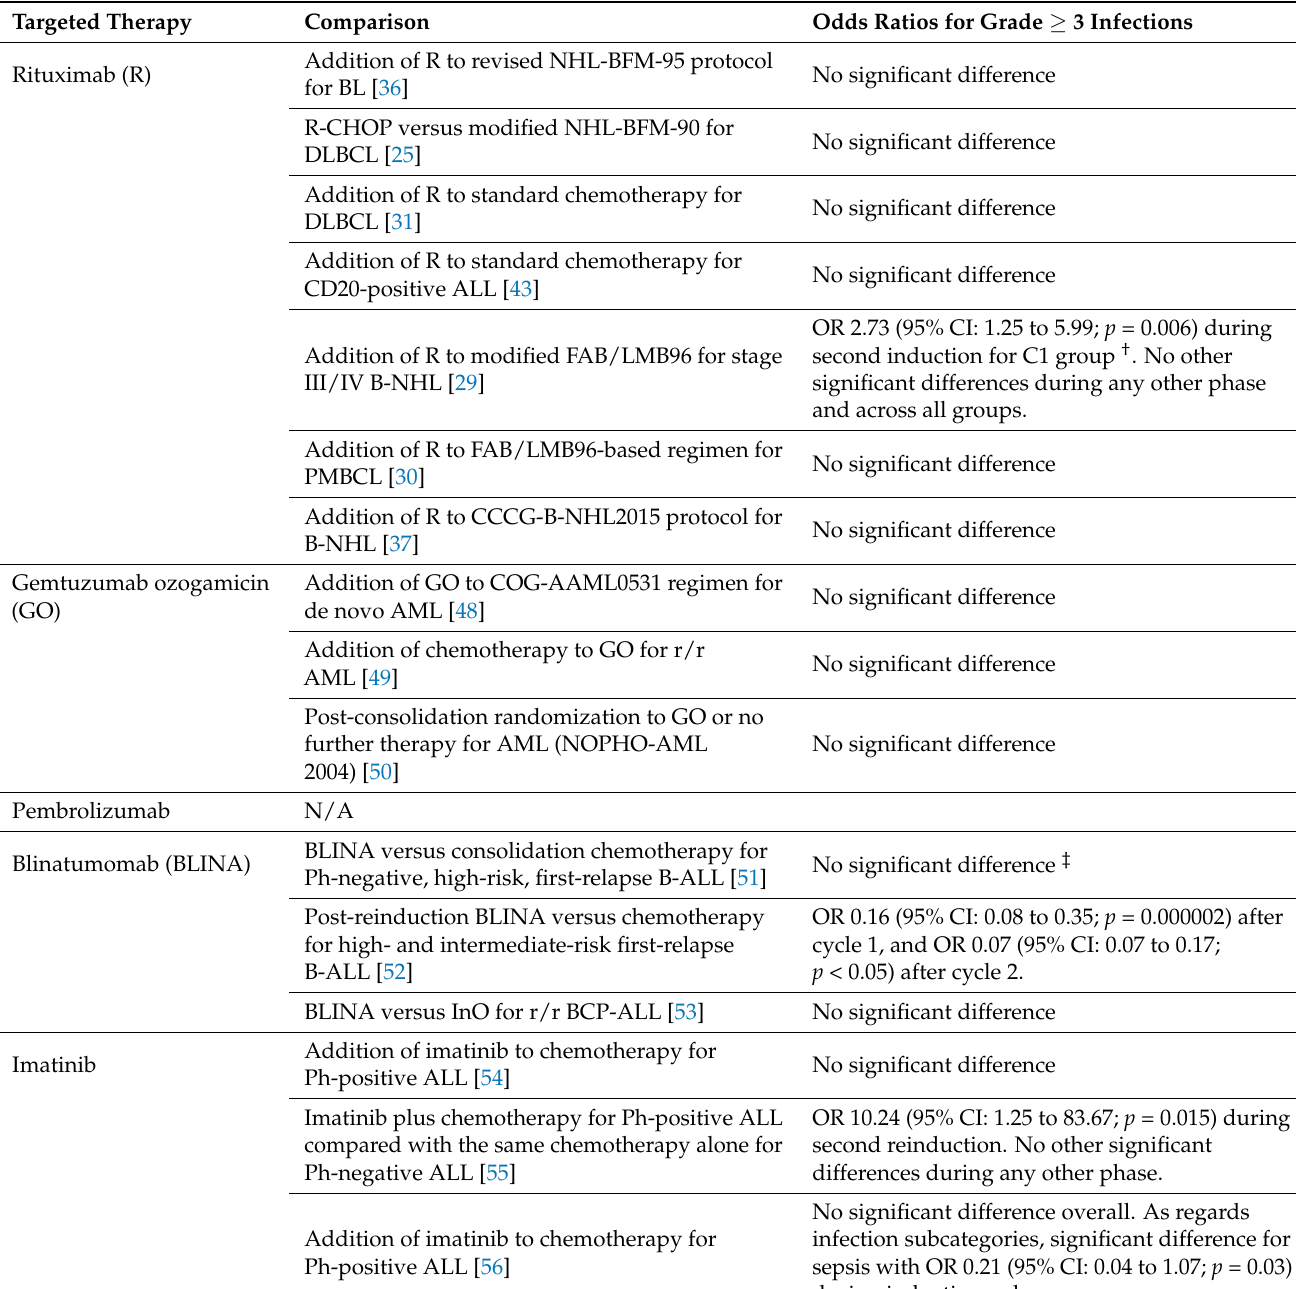
Table 2. Pooled odd ratios for grade ≥ 3 infections with targeted therapies in pediatric population treated for leukemias and lymphomas based on